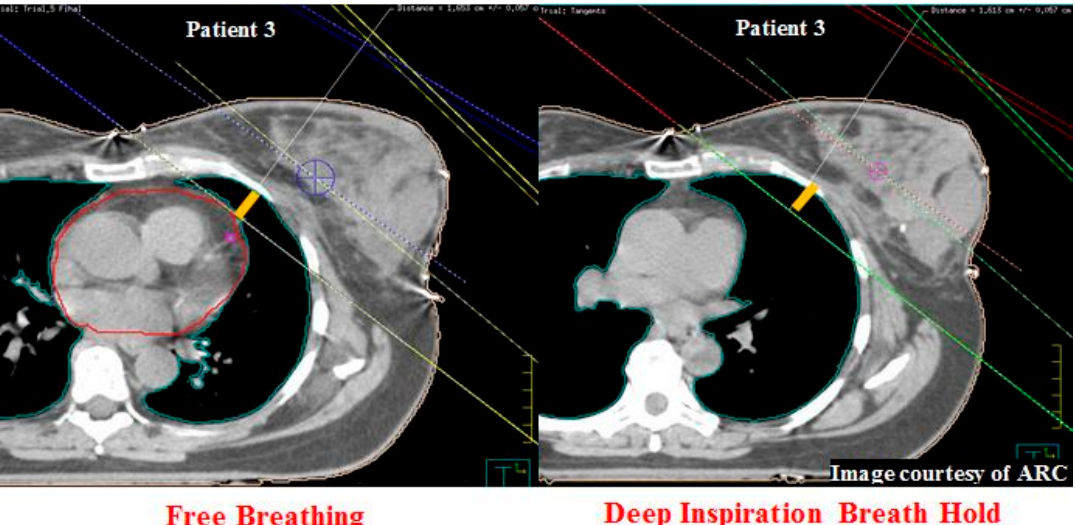
Figure 3. Central lung distance (CLD) (yellow) measured across FB (left) and DIBH (right) plans for patient 3 was identical (Image Courtesy of ARC). Cancers 2019 , 11 , x